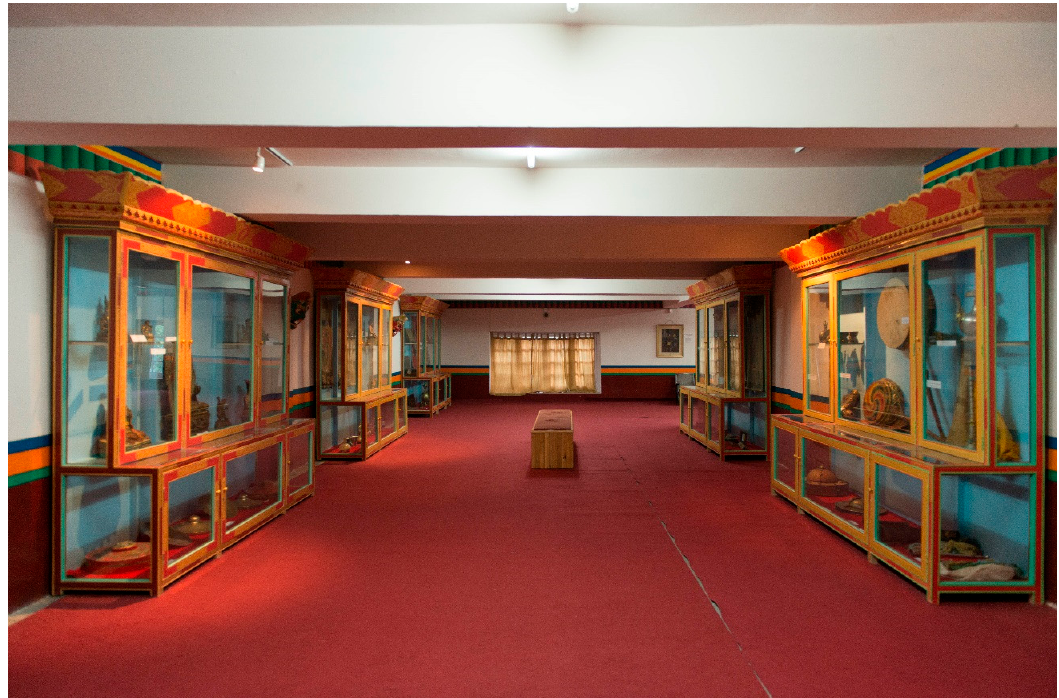
Figure 9. The Hemis Monastery Museum, Ladakh (photo C. Luczanits 2013).